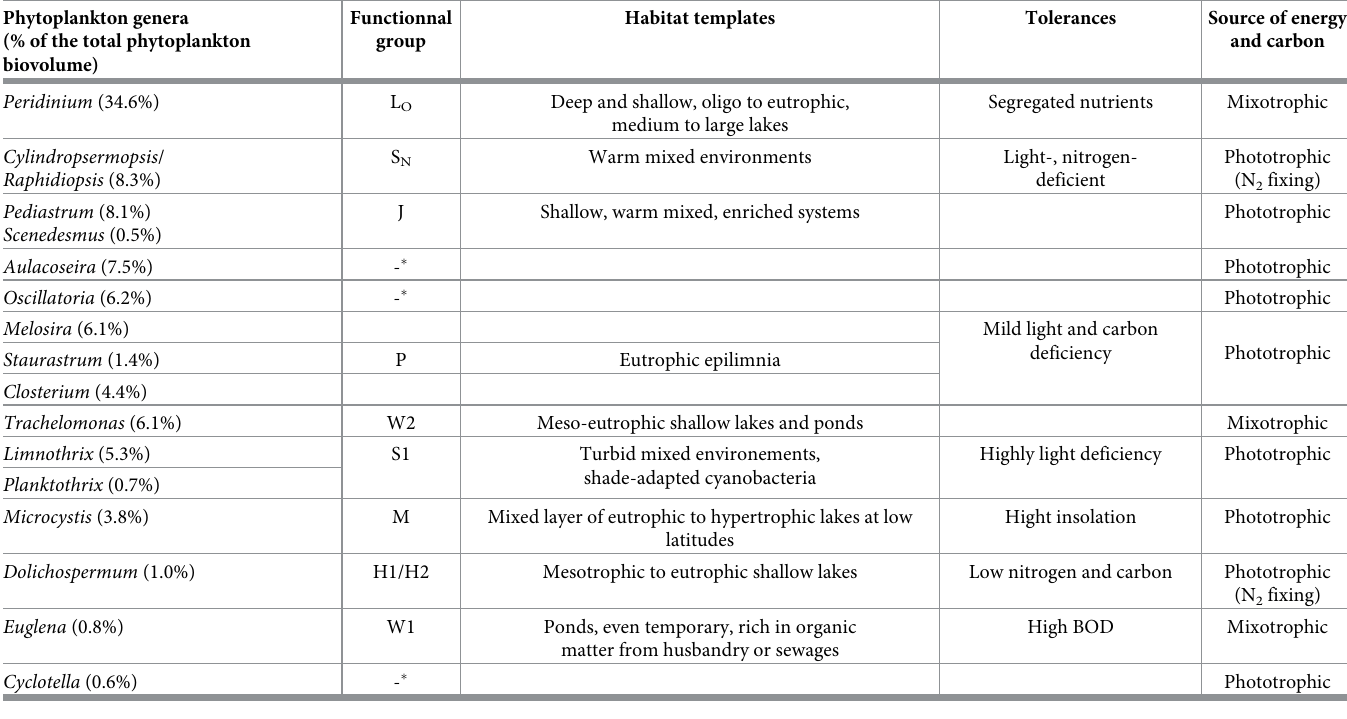
Table 2. Functional classification of the dominant genera in the phytoplankton community of Lagoon Aghien. Phytoplankton genera (% of the total